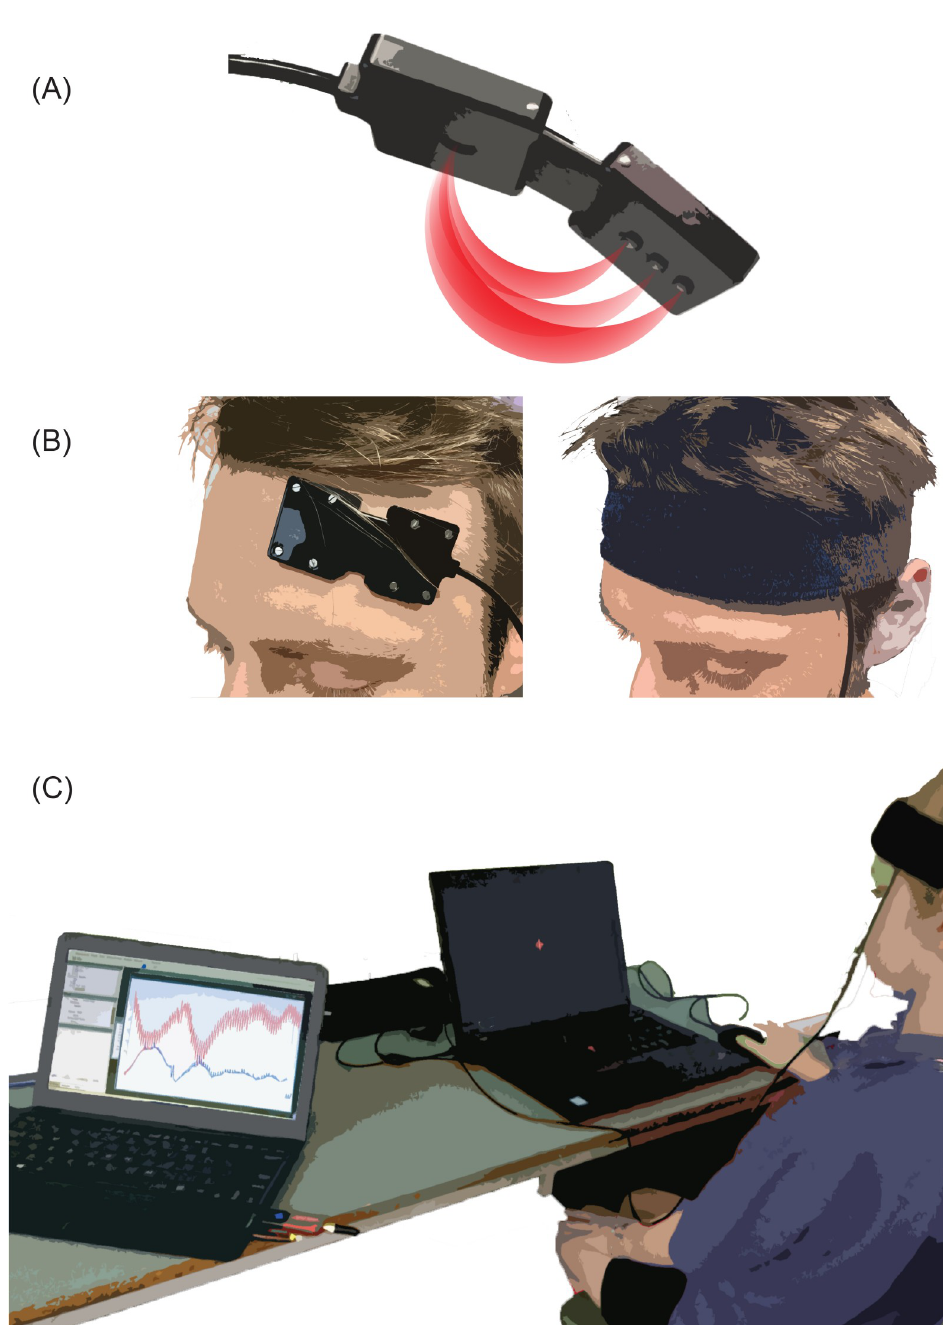
Fig 2. Functional Near-Infrared Spectroscopy (fNIRS) device and experimental setup. ( A ) The Portalite fNIRS probe (Artinis Medical Systems) with graphical representation of the three light sources (right) and the detector (left); ( B ) placement of the probe; ( C ) experimental